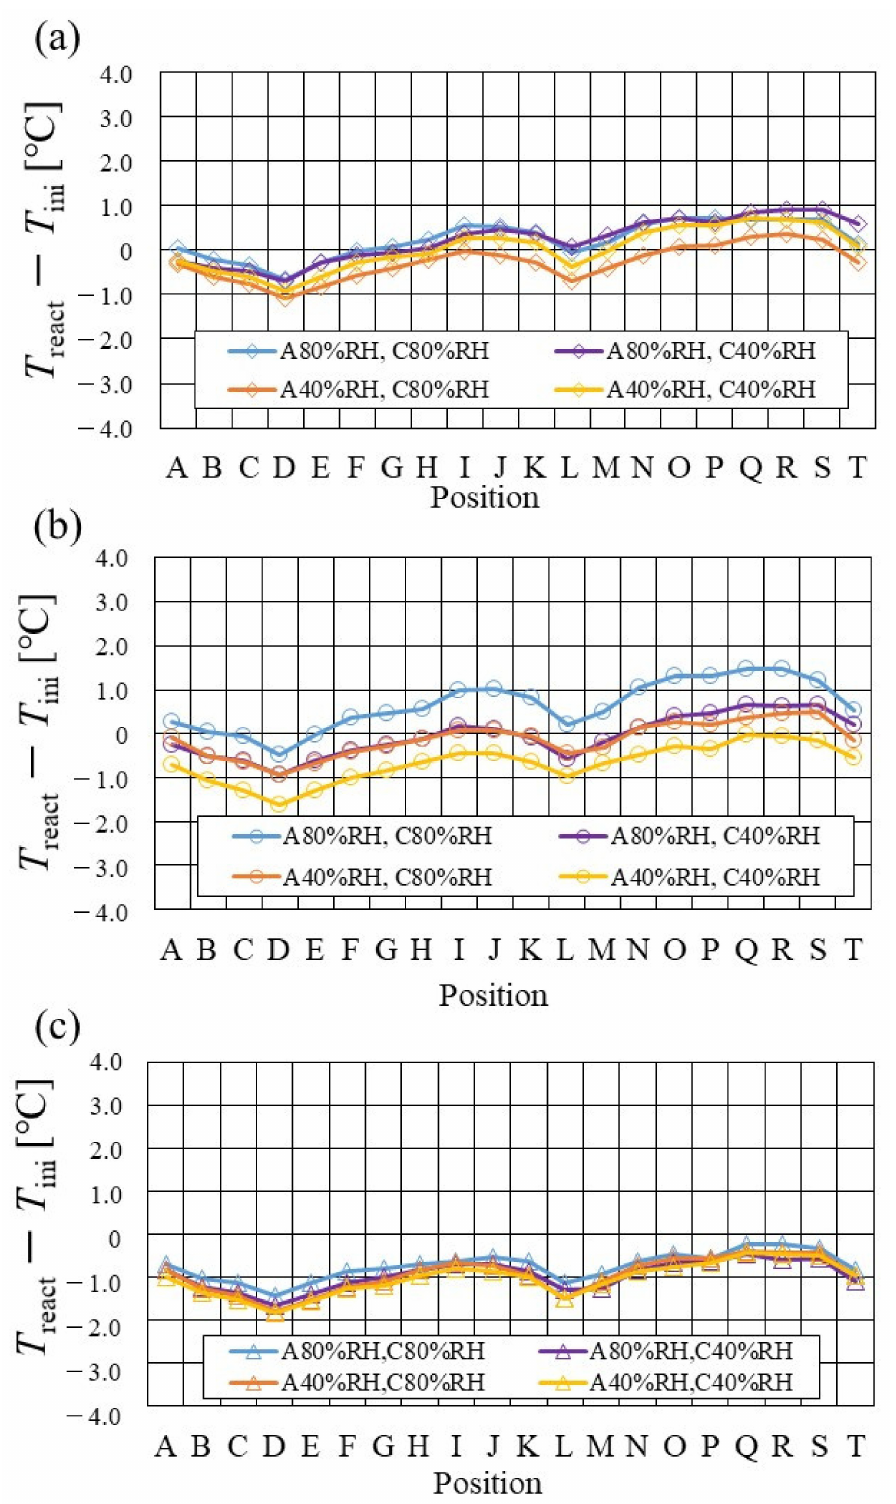
Figure 7. Comparison of distribution of temperature difference, between temperature at reaction sur- face and initial operation temperature, among different relative humidity conditions and initial opera- tion temperature, for the separator thickness of 2.0 mm: ( a ) the initial operation temperature = 80 ◦ C, ( b ) the initial operation temperature = 90 ◦ C, ( c ) the initial operation temperature = 100 ◦